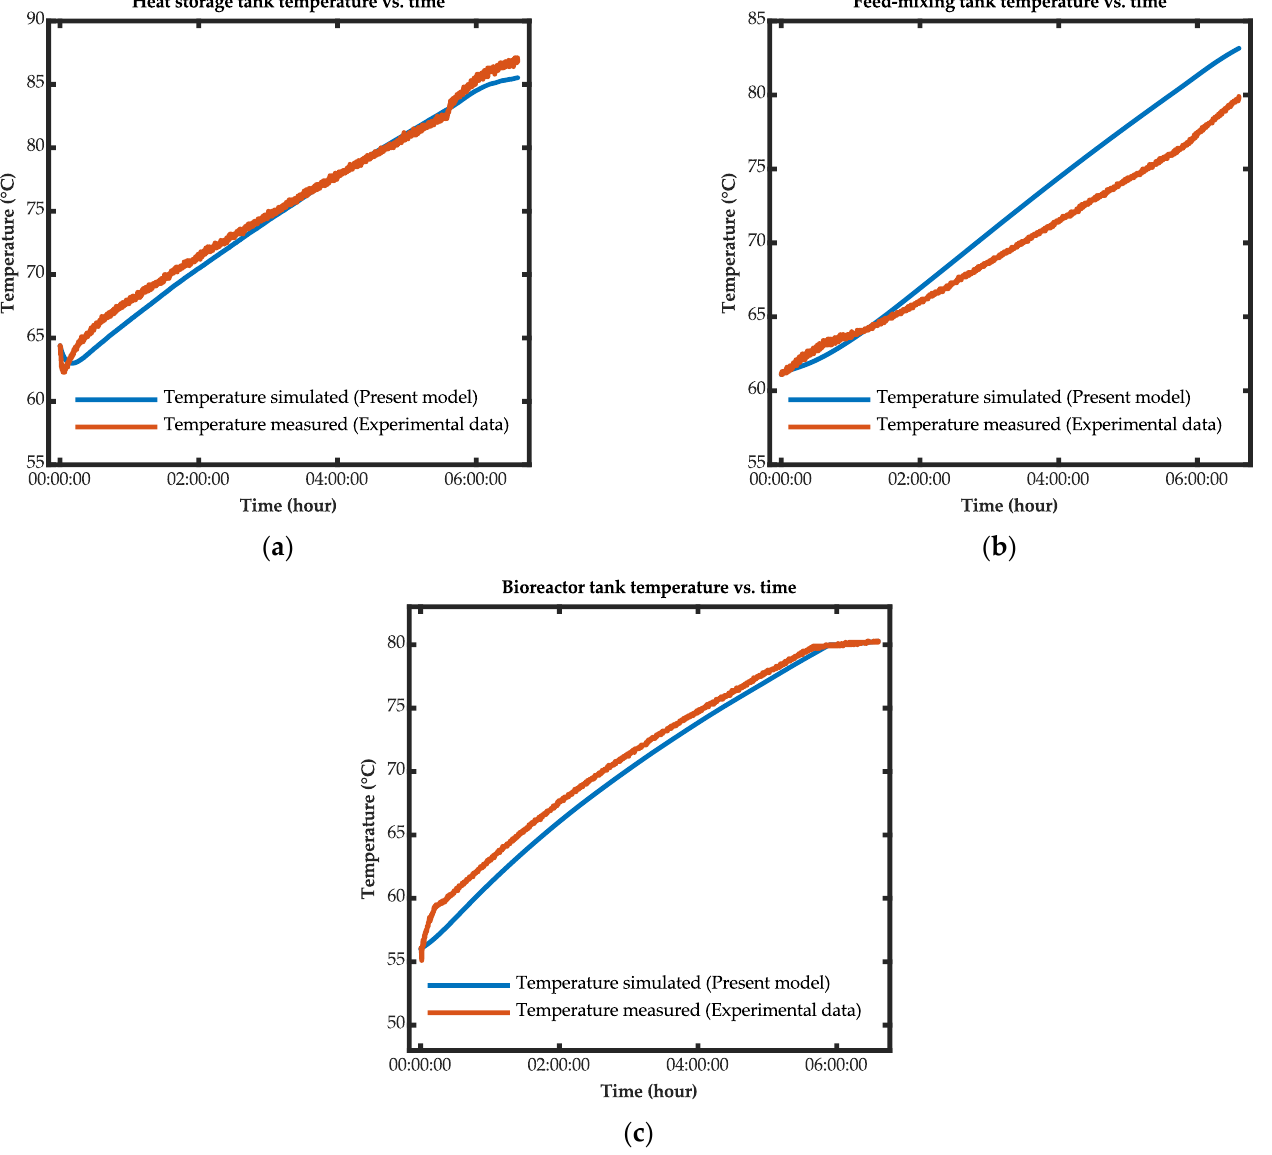
Figure 15. Comparison between the simulated results and the experimental data for the ( a ) heat storage tank, ( b ) feed-mixing tank, and ( c ) bioreactor tank.